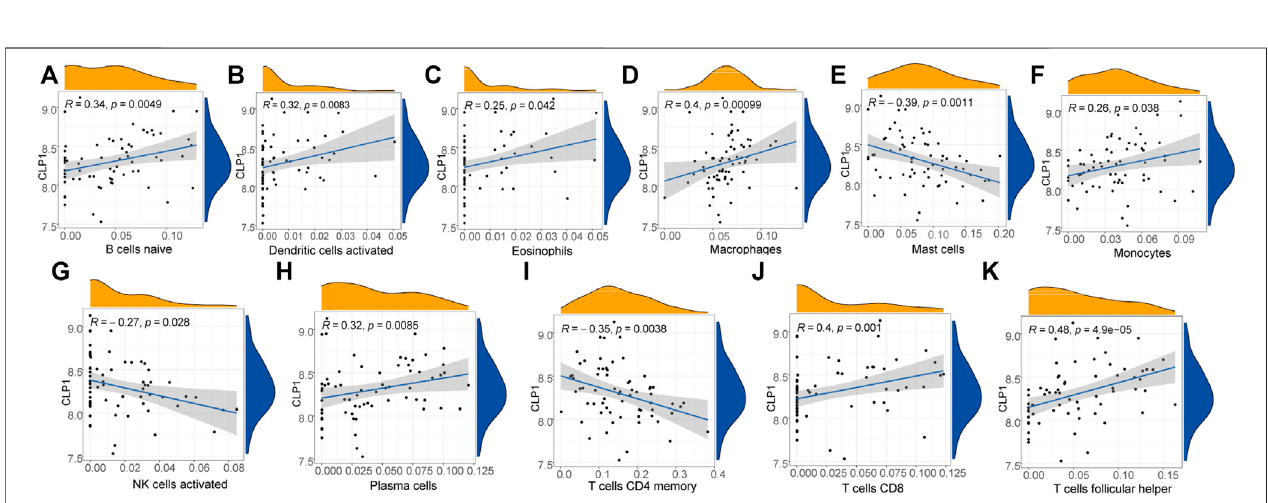
FIGURE 14 | Diagnostic marker gene and immune correlation analysis. (A – K) : CLP1 gene correlation analysis with immune cells, the slope is the correlation size, and the Pvalue represents the signi fi cance level.